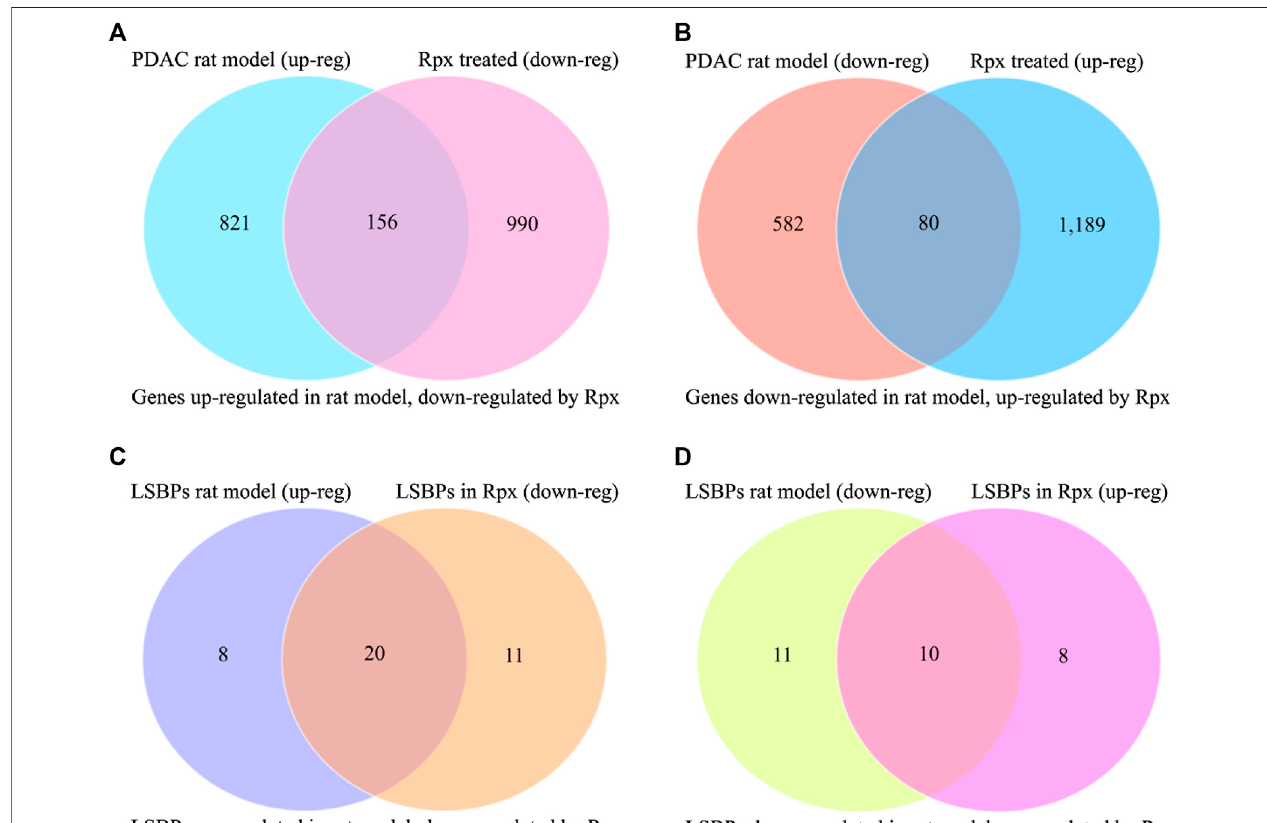
FIGURE 8 | Analysis of Rpx in fl uence on Suit2-007 genes potentially driving cancer progression. The Venn diagrams show genes, which were up-regulated in a PDAC rat progression model but down-regulated by Rpx in vitro (A) or vice versa (B) . When identifying common genes between the LSBPs derived from Supplementary Figures S1A,B , which are analyzed in Table 1 (389 genes in total), 49 LSBP genes emerged. (C,D) Show the respective modulation of these LSBP genes, which were up-regulated in the PDAC rat progression model but down-regulated by Rpx in vitro (C) or vice versa